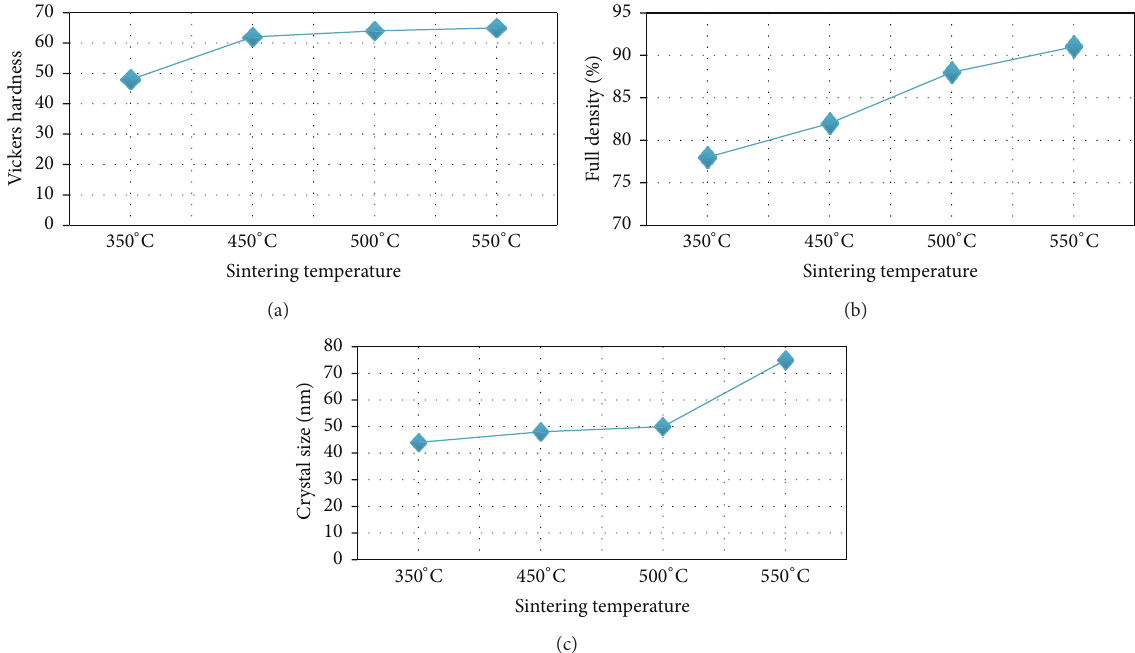
Figure 5: Effect of sintering temperature for the powders cryomilled for 7 hours for sintering of 3 minutes and high heating rate: (a) Vickers hardness, (b) percentage of full density, and (c) crystal